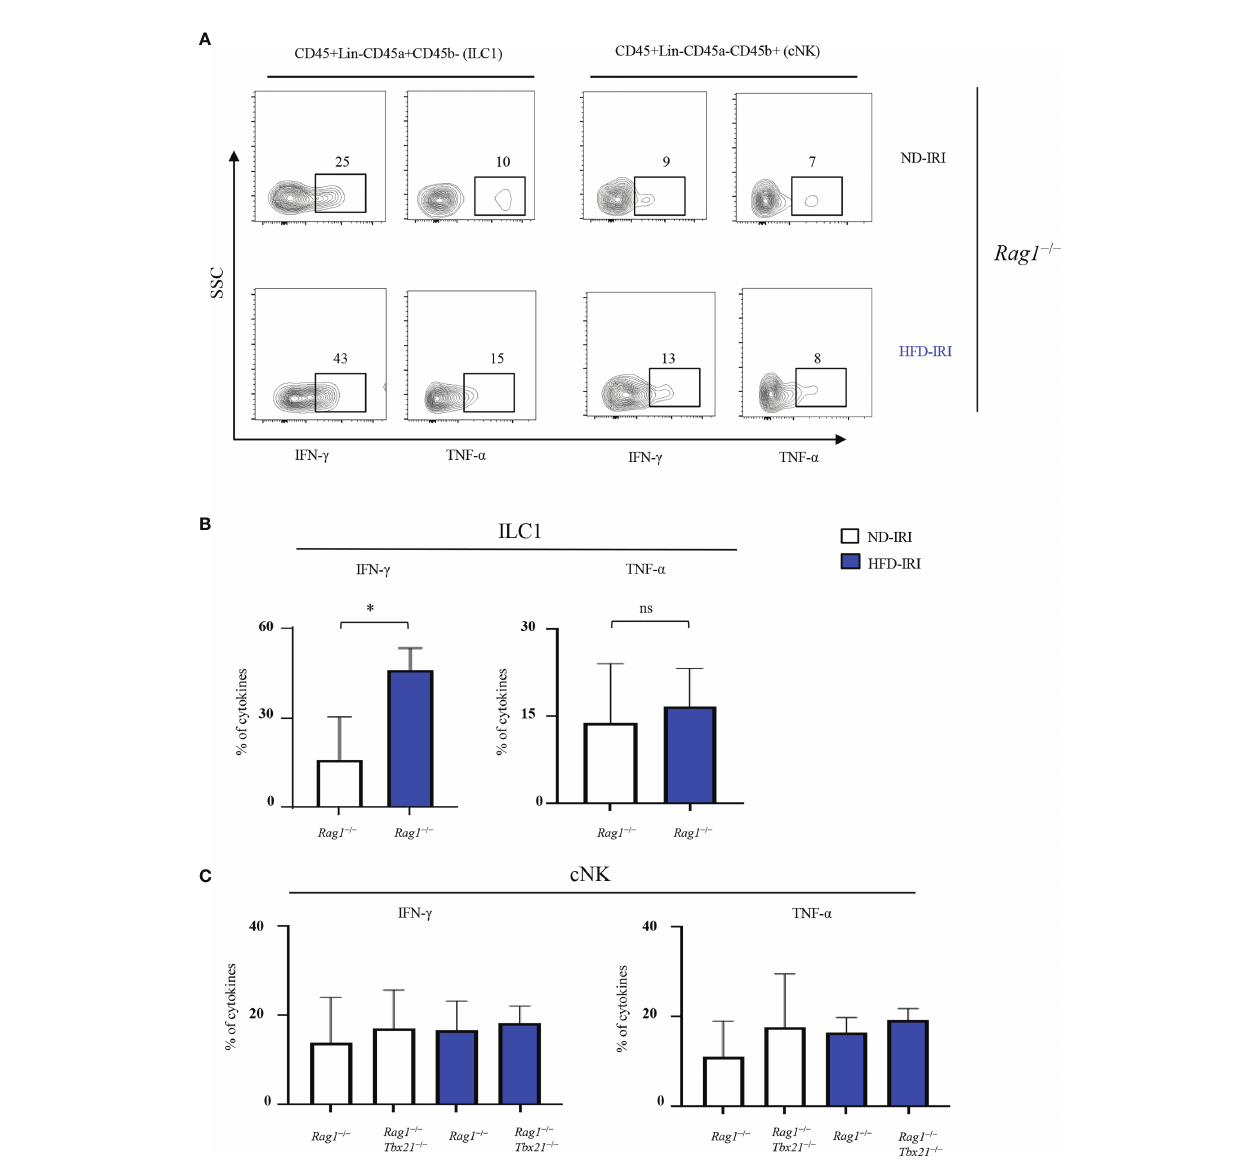
FIGURE 4 | ILC1s produce higher IFN- g in HFD-IRI. (A) Representative fl ow plots showing intracellular cytokine production (IFN-g + and TNF- a + cells) in ND-IRI and HFD-IRI Rag1 − / − mice. FACS plots gated on live, CD45 + , Lin - , NK1.1 + , CD49a + and CD49b - for ILC1s and CD45 + , Lin - , NK1.1 + , CD45a - and CD45b + for cNKs. (B) Percentage of cytokines from ILC1 gated cells in ND-IRI and HFD-IRI Rag1 − / − mice. (C) Percentage of cytokines from cNK gated cells in Rag1 − / − and Rag1-Tbet DKO mice (n=3-5 mice per group). Signi fi cance was determined using Mann Whitney Test. *p<0.05; ns, not signi fi